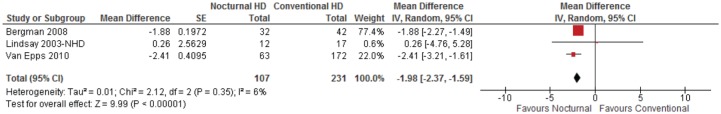
Comparative mean difference in hospitalization days/patient-year for nocturnal home HD versus conventional HD.